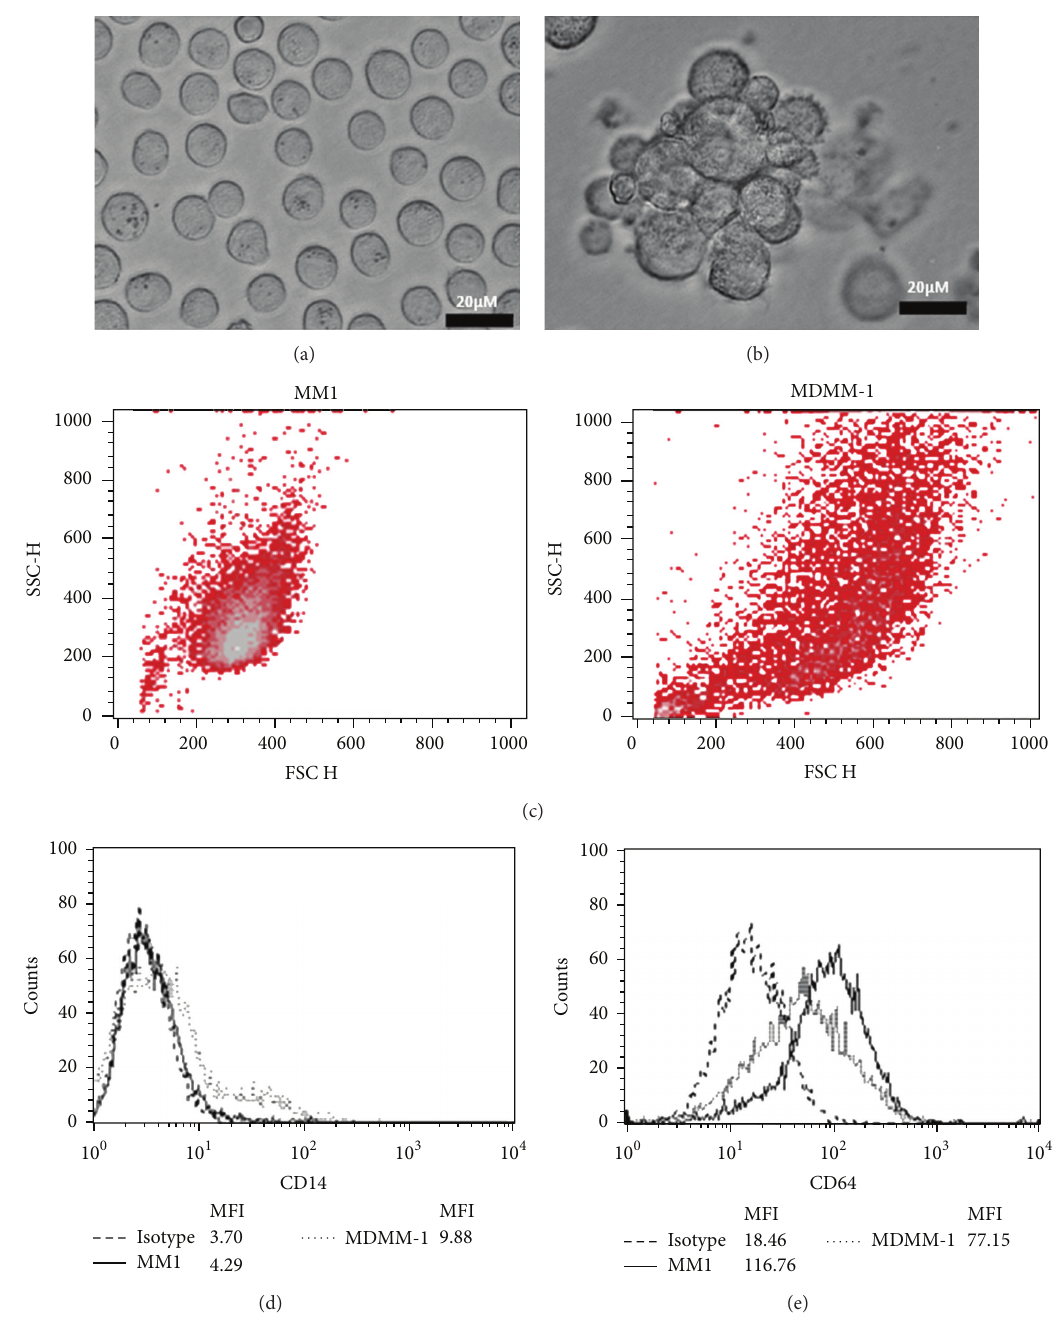
Figure 1: Differentiation of Mono Mac-1 cells into MDMM-1 cells. Representative interferential contrast images of Mono Mac-1 (a) and MDMM-1 (b) cells after 72 h of differentiation with 20 ng/mL PMA, as well as forward light scatter and side light scatter plots (c). CD14 (d) and CD64 (e) expression was analyzed by flow cytometry before and after differentiation. Data shown are representative of three